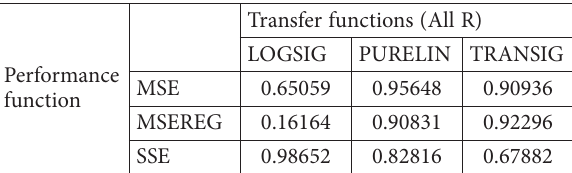
Table 4. Results for various Transfer functions for all R of the system